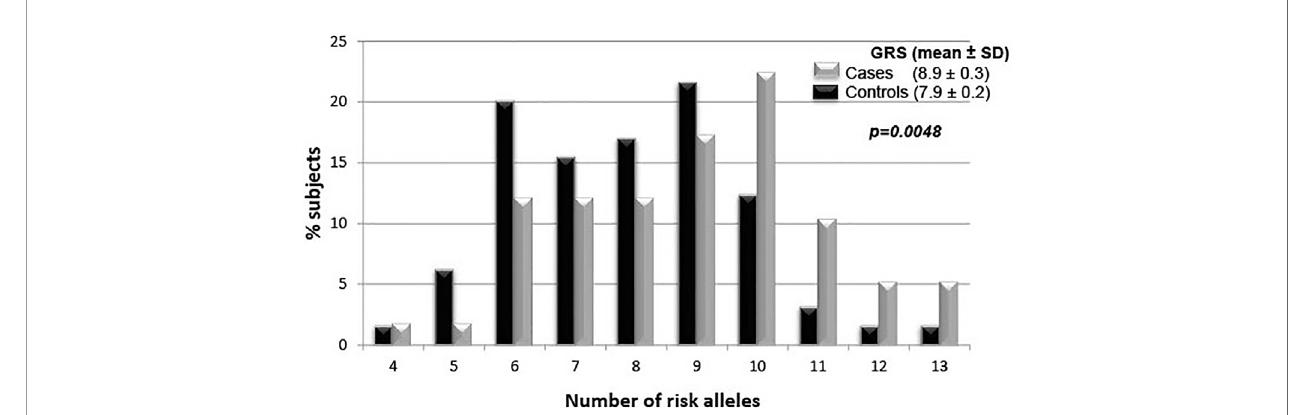
FIGURE 2 | Genetic risk score density of the 10 single nucleotide polymorphisms between cases and controls.